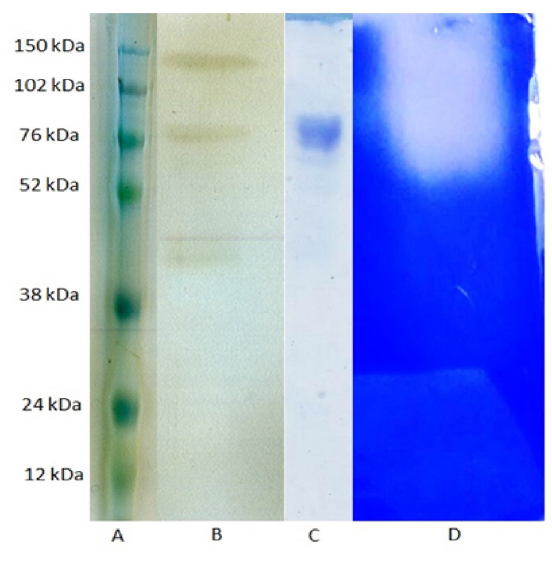
Figure 2. Molecular weight determination of fibrinolytic protease purified from Mucor subtilissimus UCP 1262 using by SDS-PAGE (a); (b) and fibrin zymography (c). (M) protein standard marker (Full Range RPN800E - GE Healthcare); (a) SDS-PAGE was carried out on a 12 % polyacrylamide gel and was stained with silver nitrate showed the purified fibrinolytic protease by DEAE Sephadex; (a) Purified fibrinolytic protease by Superdex 75 HR10/300; (c) Fibrin zymography was carried out on a 12 % polyacrylamide gel contain fibrin and was stained with Coomassie Brilliant Blue